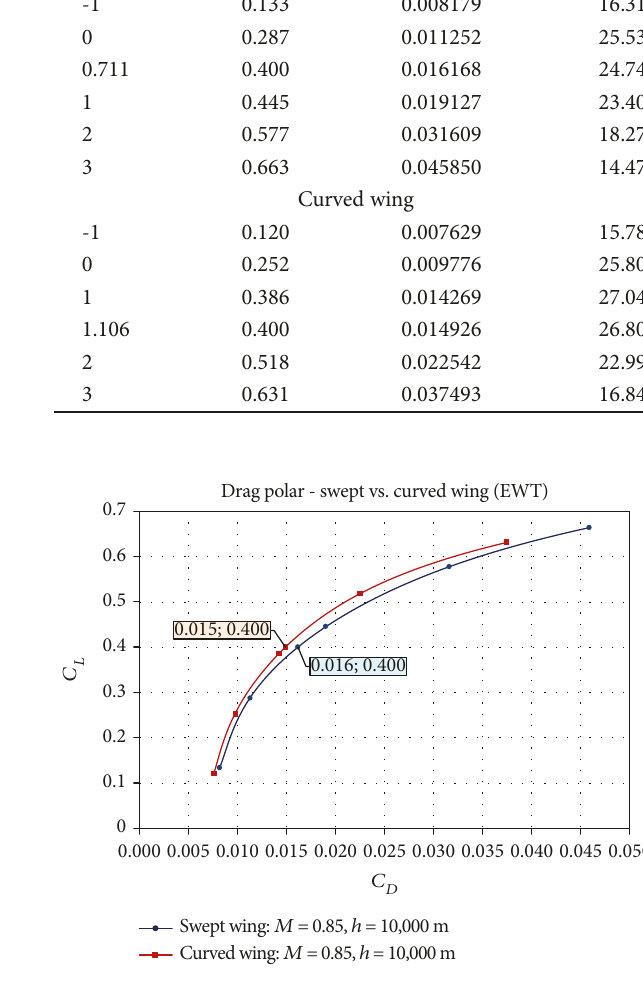
Figure 12: Drag polar curves ( M = 0 85 , h = 10,000 m